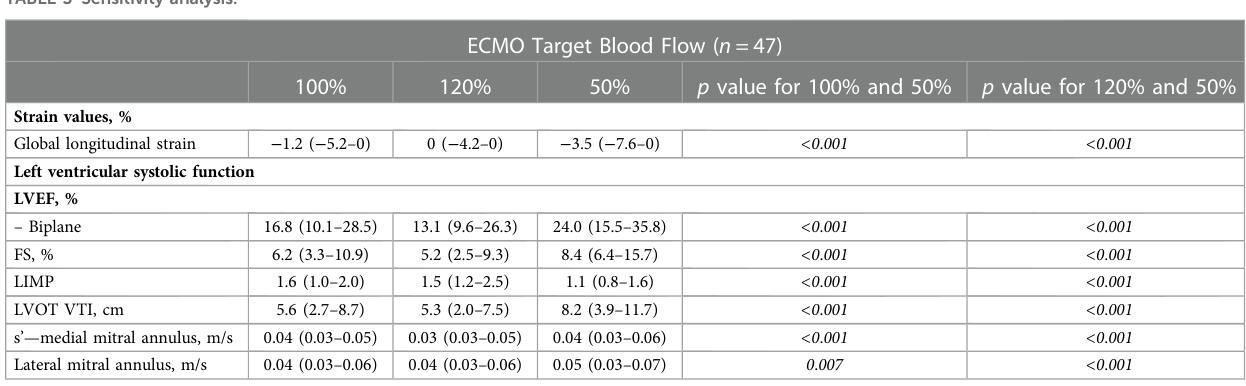
TABLE 3 Sensitivity